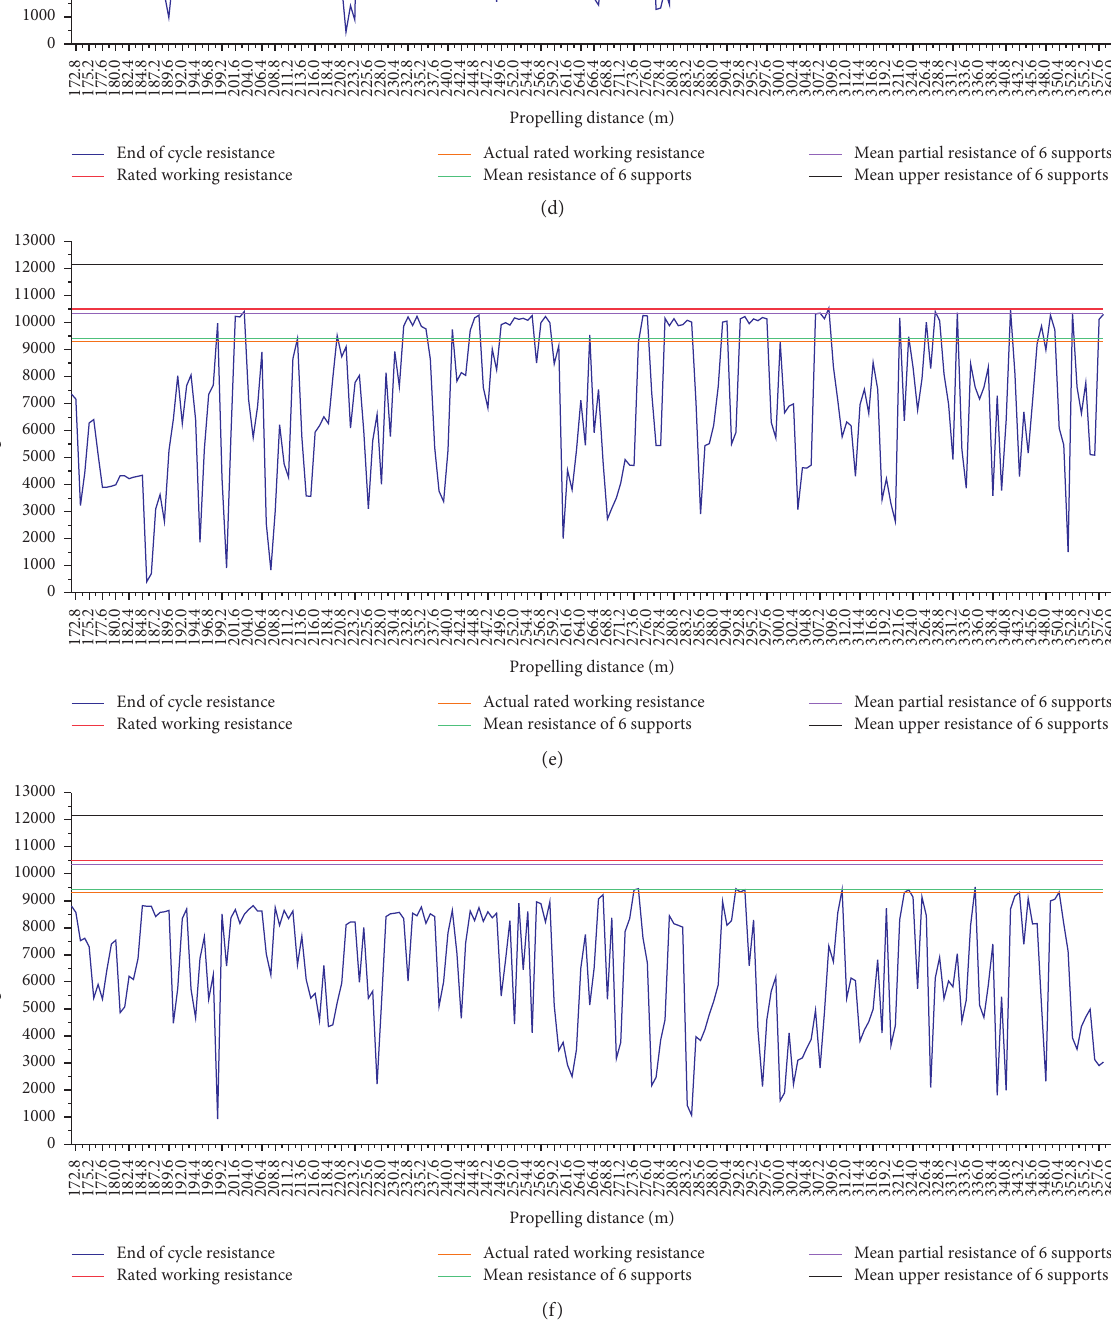
Figure 11: 5 kinds of working resistance relationship of 6 key supports: (a) 62# support, (b) 64# support, (c) 67# support, (d) 89# support, (e) 108# support, and (f) 120#